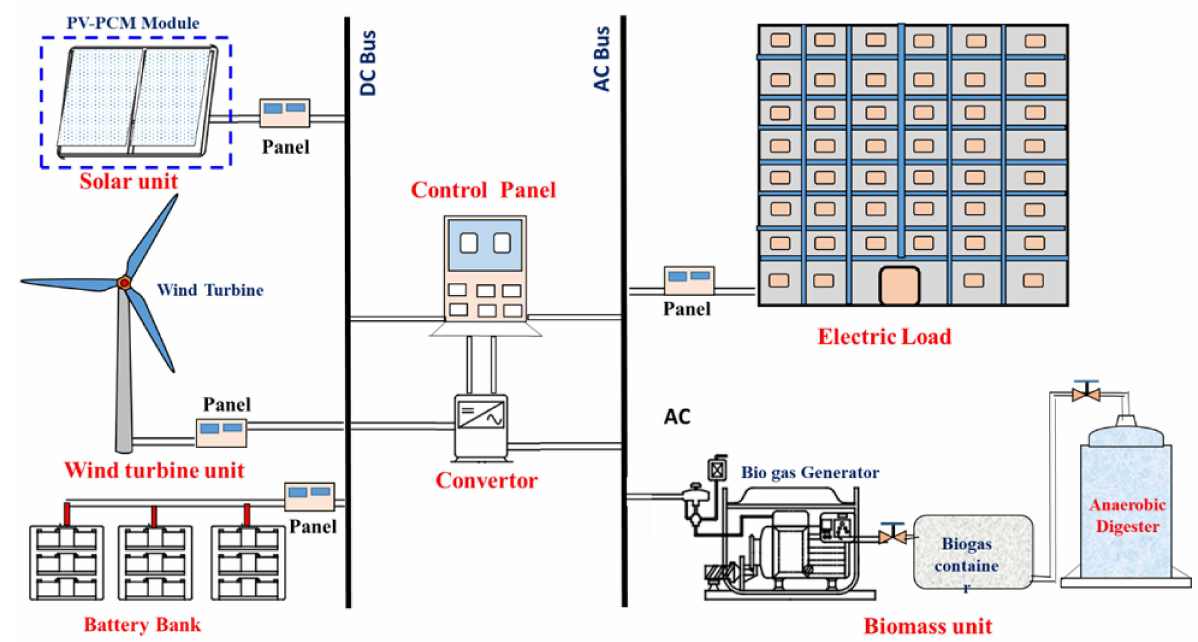
Figure 1. System representation of Hybrid renewable energy